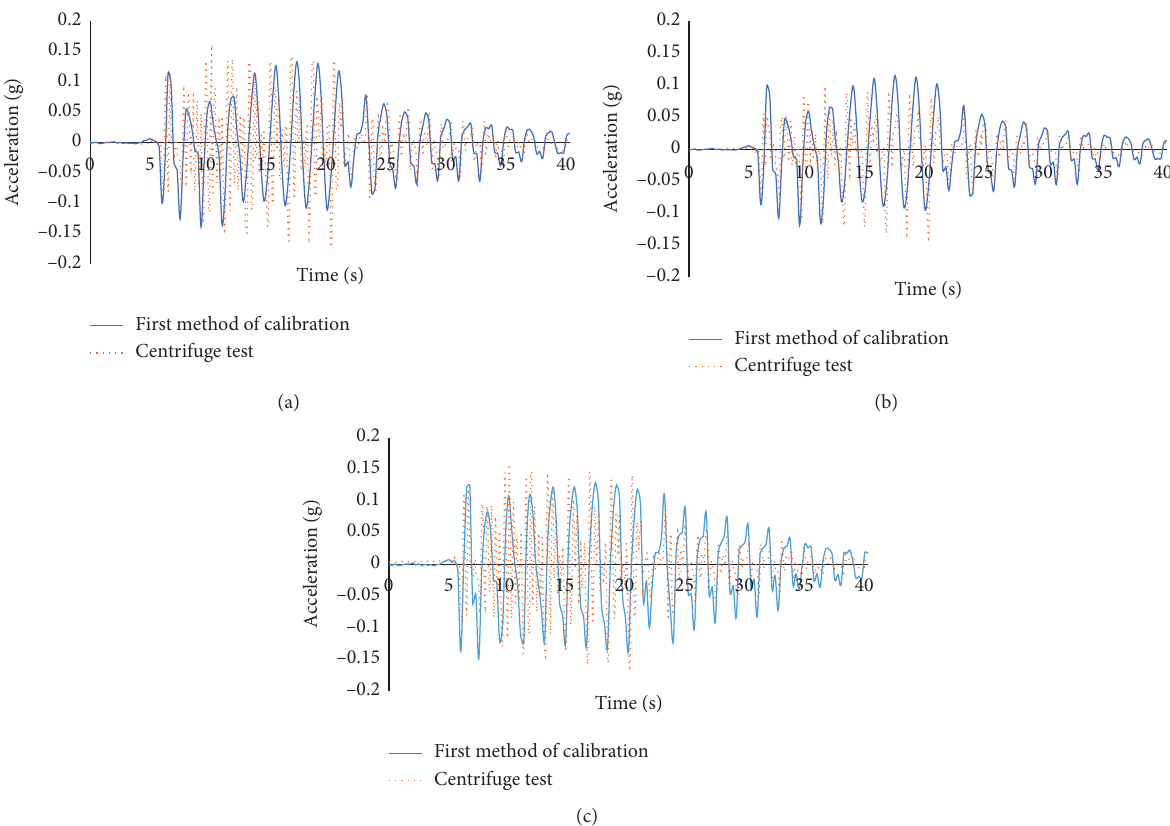
Figure 11: Maximum acceleration response of pile under input motion-1: (a) single pile, (b) pile group-1, and (c) pile group-2.